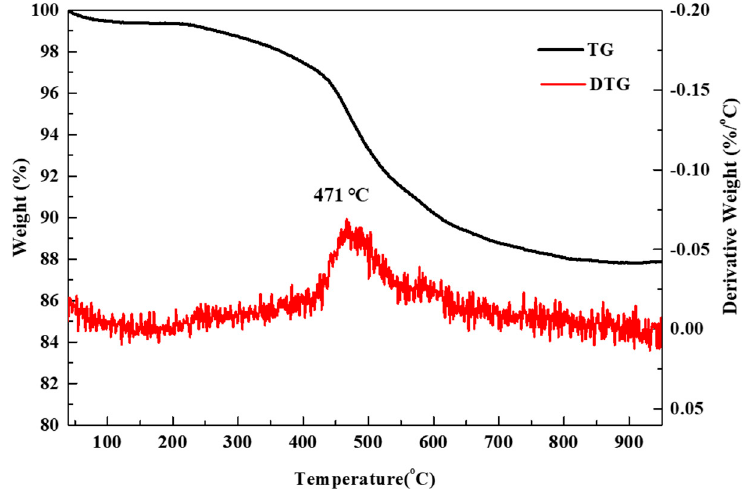
Figure 3. TG and its derivative curves for the silica aerogel powder.